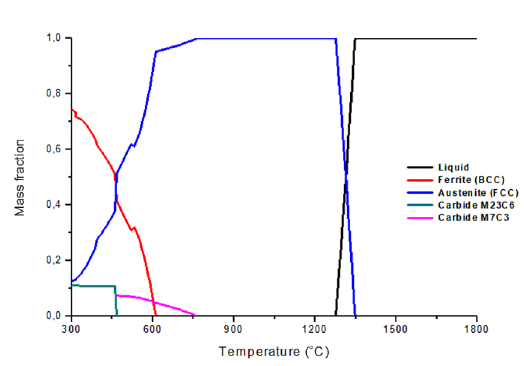
Figure 3. Mass fraction diagram of the 22% manganese steel. Source: author